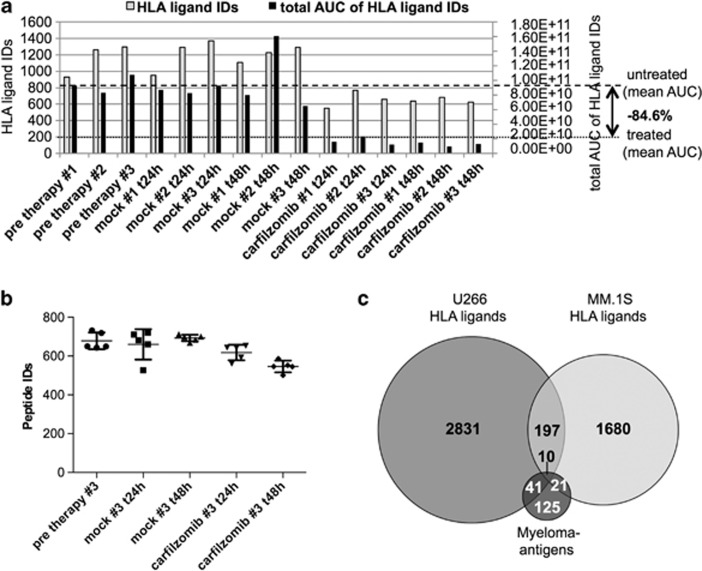
Mass spectrometric analysis of the HLA-presented peptidome of MM.1S cell under carfilzomib treatment. (a) HLA class I ligand extracts of MM.1S cells before in vitro treatment and 24 h/48 h (t24h, t48h) after a 1-h pulse with 100 nm carfilzomib (Carfilzomib) or 5% glucose (Mock) were analyzed in biological triplicates using sample shares of 20% in dose-finding mass spectrometry runs. The raw number of HLA ligand identifications and the summed area under the curves (AUC) of their extracted ion chromatograms are indicated in gray and black bars, respectively. (b) Numbers of peptide identifications after adjustment of the injected sample amounts. The sample amounts were adjusted according to their ratios of summed AUC and each condition was analyzed in five technical replicates, allowing for LFQ of the relative peptide abundances. (c) Overlap of the 1908 different HLA class I ligands identified on MM.1S cells compared with a set of 197 different myeloma-associated peptides described in an earlier study.18